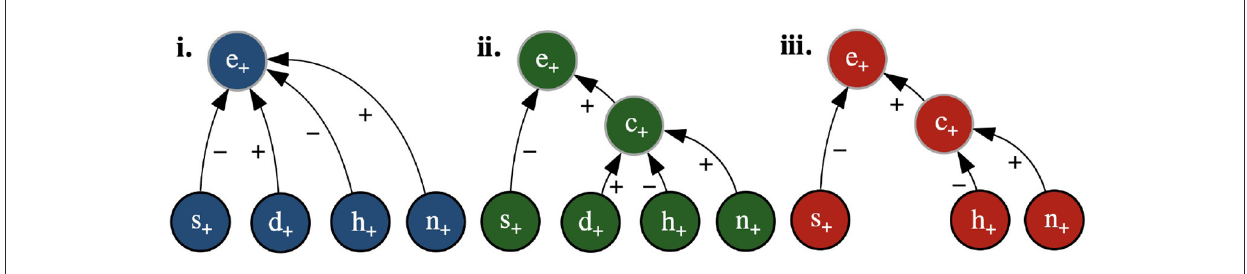
FIGURE1 Example RXs (shown as graphs, with positive and negative reasons given by edges labeled + and − , resp.) with input x such that x ( s ) = x ( d ) = x ( h ) = x ( n ) = + (represented as s + , d + , h + , n + ) and (resulting) class values c = + (represented as c + ) and e = + (represented as e + ).